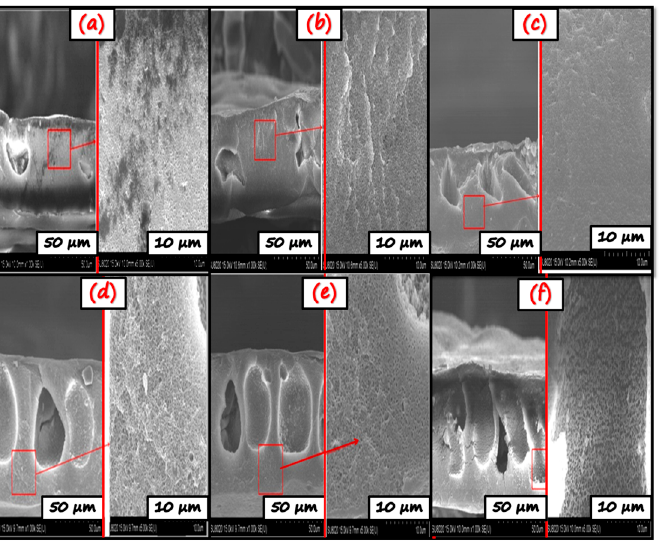
Figure 8. SEM cross-section morphology of ( a ) CA, ( b ) TiO 2 -CA, ( c ) GO-CA, ( d ) NC(1)-CA, ( e ) NC(2)-CA and, ( f ) NC(3)-CA.